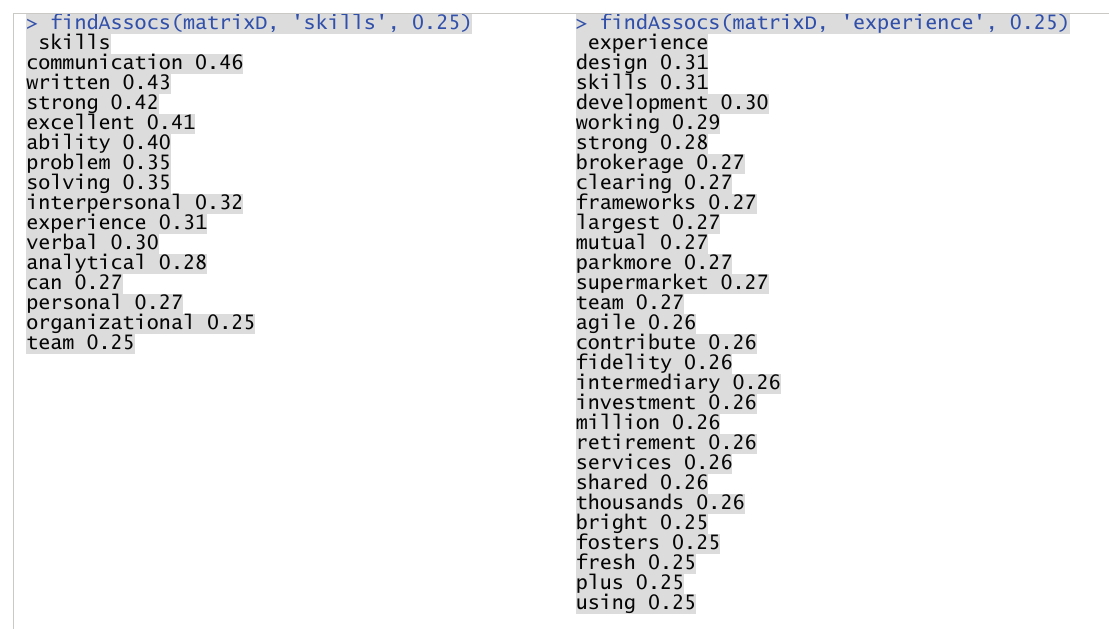
Figure 5. Selected terms associations within JobTitle.